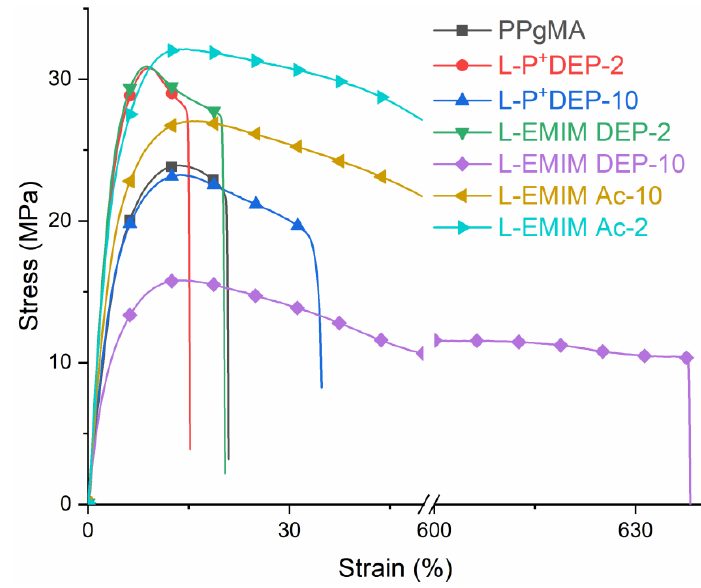
Figure 10. Stress – strain curves from tensile tests for of PPgMA and related LIonomers. Figure 10. Stress–strain curves from tensile tests for of PPgMA and related Table 5. Mechanical properties of PPgMA and related LIonomers (from tensile tests performed at room temperature).